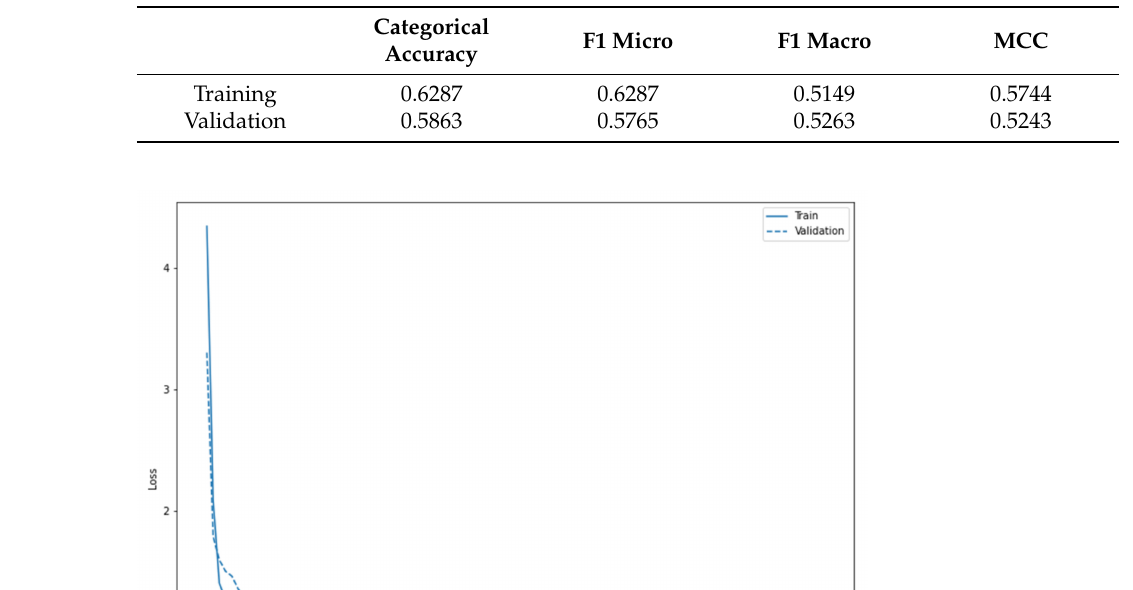
Table 6. Performance results for the feed-forward neural network.